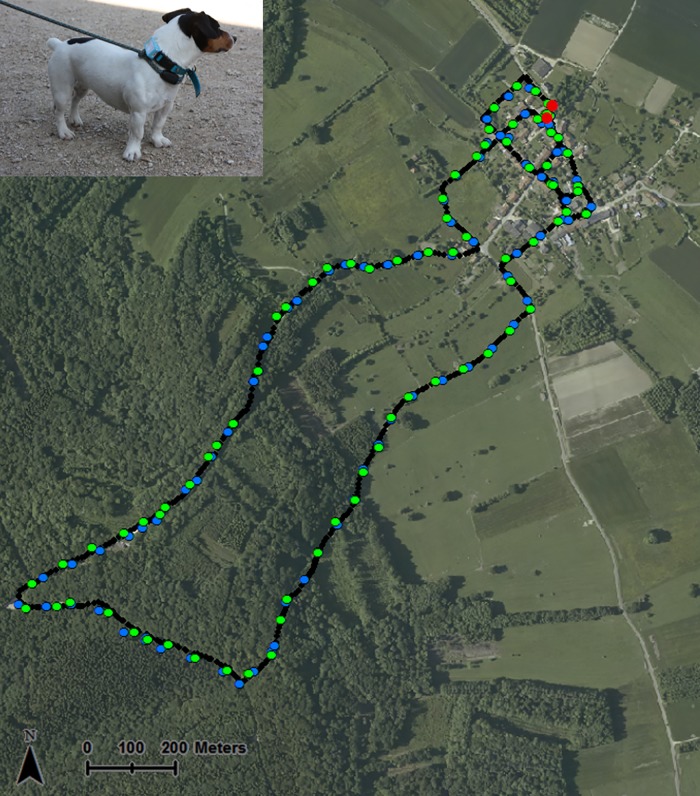
Motion controlled tests.Locations recorded by the Garmin control device (small dark dot) and two CatLog data loggers (large green and blue dots) with a fix interval set to 1 min along the path centered on Briquenay. Red points represent starting and ending points.